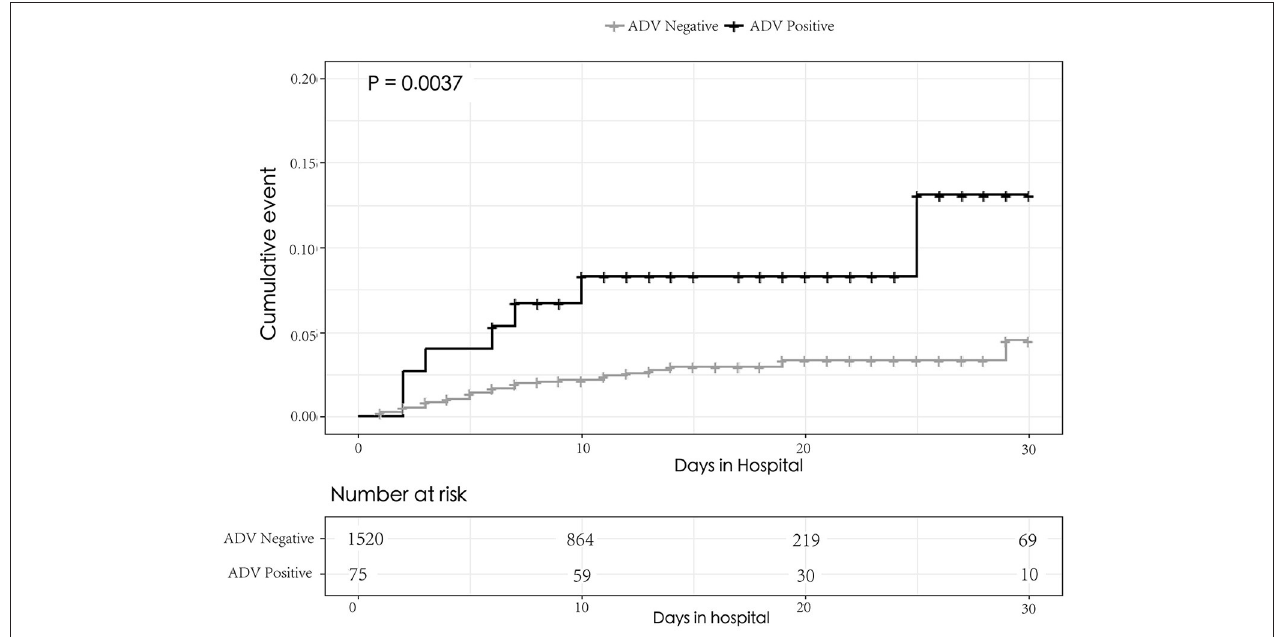
FIGURE 2 | Kaplan–Meier graphs of the probability of death for 30 days in hospital between the sever pneumonia children with and without ADV infection. The curves were compared using the log rank